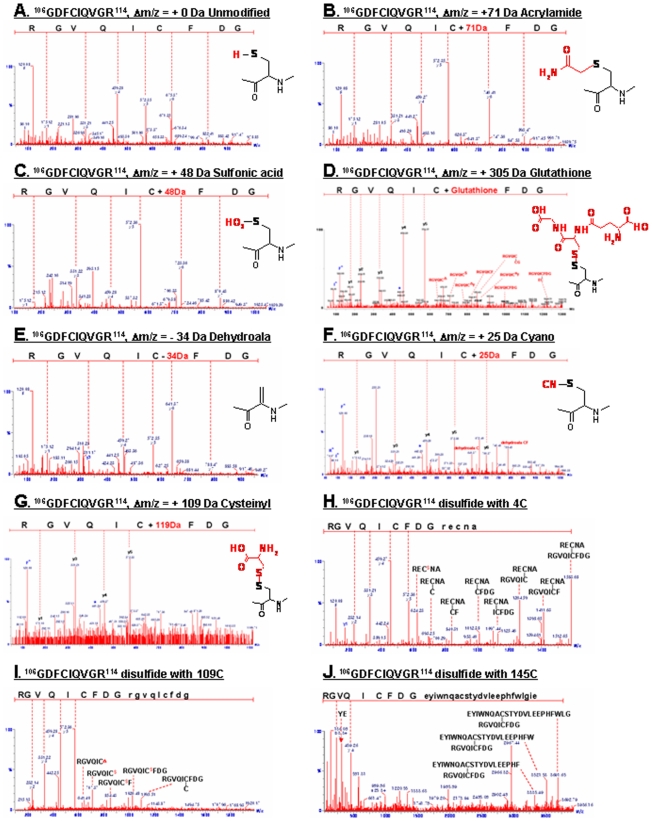
Peptide sequencing using MS/MS analysis of tryptic peptide from modified peptide at Cys-109.(A) Unmodified peptide 106GDFCIQVGR114; (B) Acrylamide adduct of free SH; (C) Oxidized C109 to sulfonic acid (-SO3H), +48 Da at C109; (D) Glutathionylated C109; (E) Dehydroalanine (Δm/z = −33.9821 Da); (F) Formation of Cys-S-CN, +25 Da; (G) Cysteinylation (109CysS-SCys, Δm/z = +119.0 Da); (H) inter-disulfide C109; (I,J) Intra-disulfide bond with Cys4 peptide (109CysS-S-AN4CER, Δm/z = +589.2075 Da) and C145 (109CysS-S-ELGLWFHPEELVDYTS145CAQNWIYE, Δm/z = +2939.2851 Da).